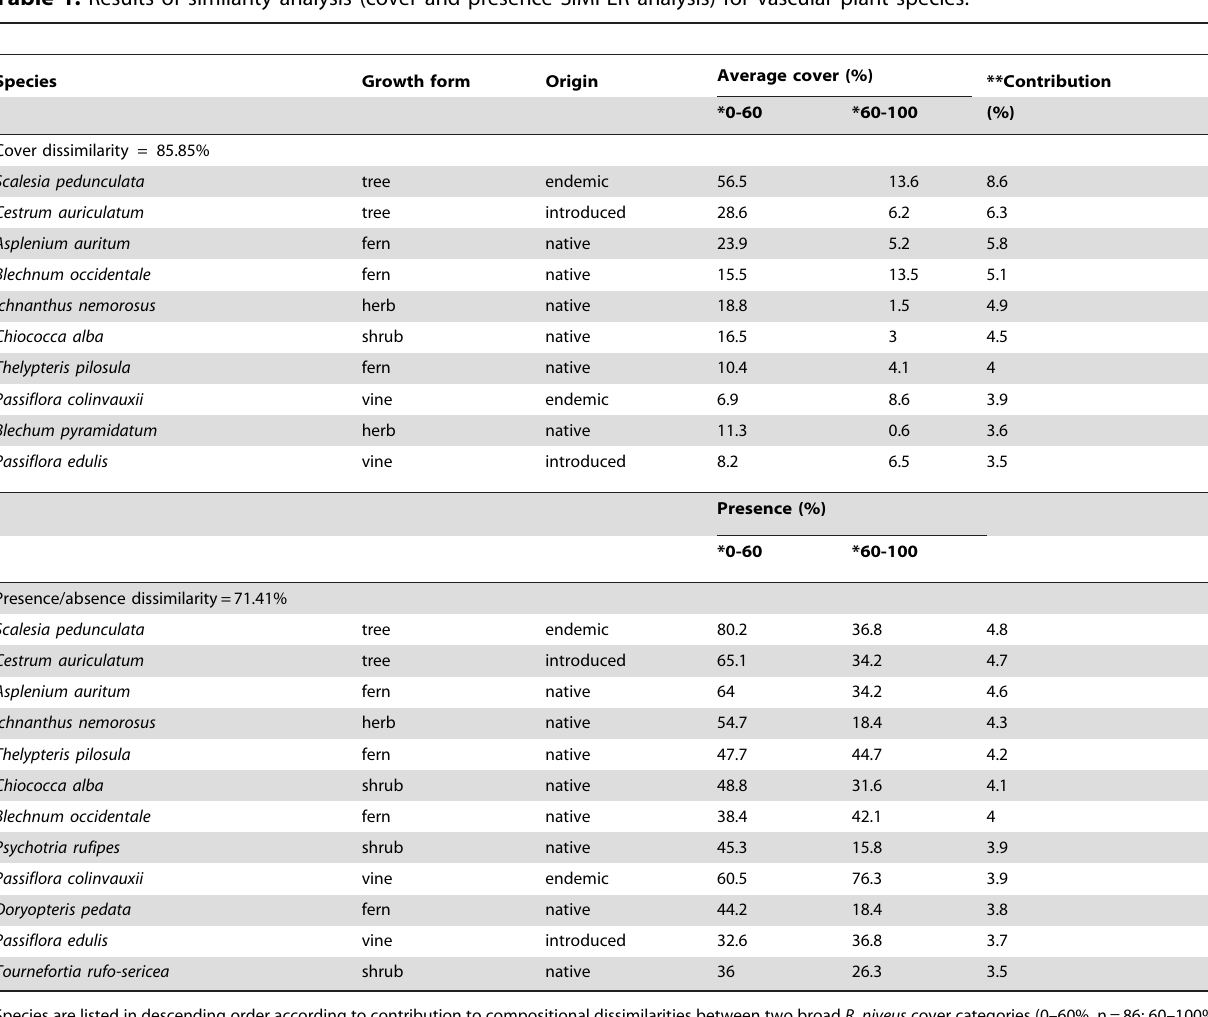
Table 1. Results of similarity analysis (cover and presence SIMPER analysis) for vascular plant species.